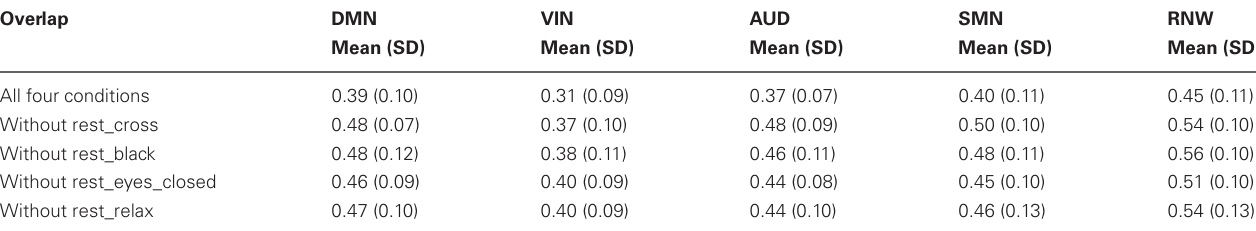
Table 1 | Mean overlap at the single-subject level for all four conditions compared to the overlap of any possible combination of three